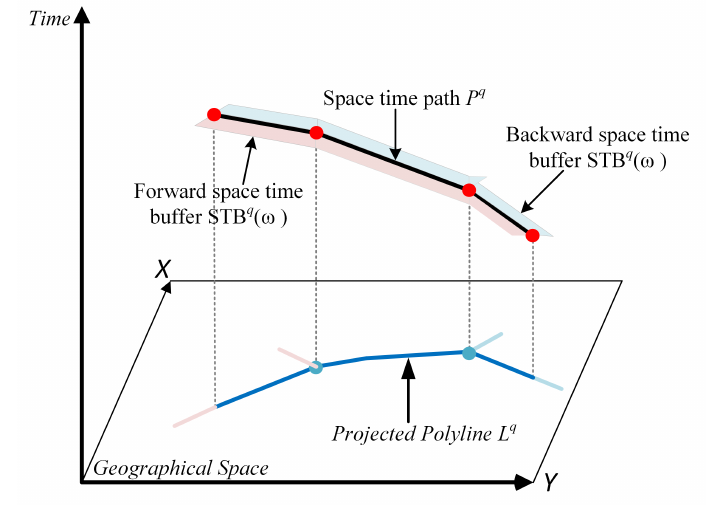
Figure 3. Network-constrained spacetime path with spacetime buffer in ( x , y , t ) space.